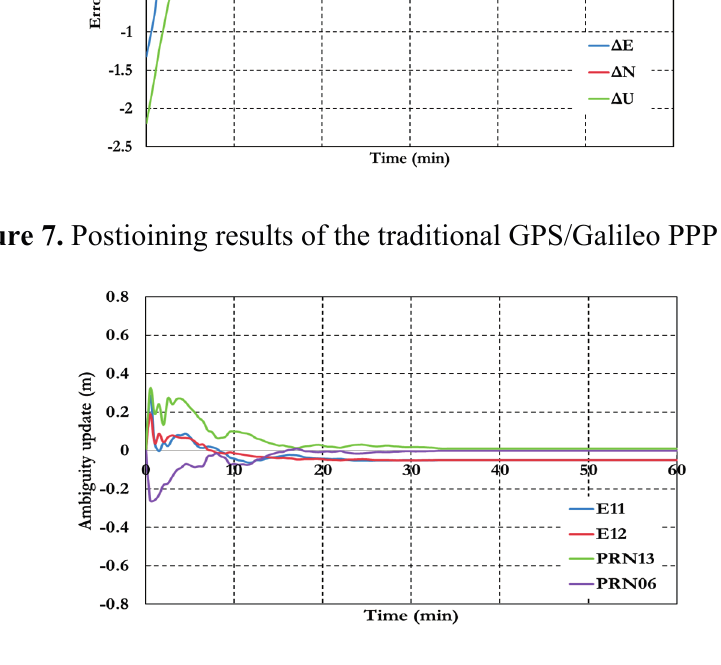
Figure 8. Ambiguity parameters the traditional GPS/Galileo PPP